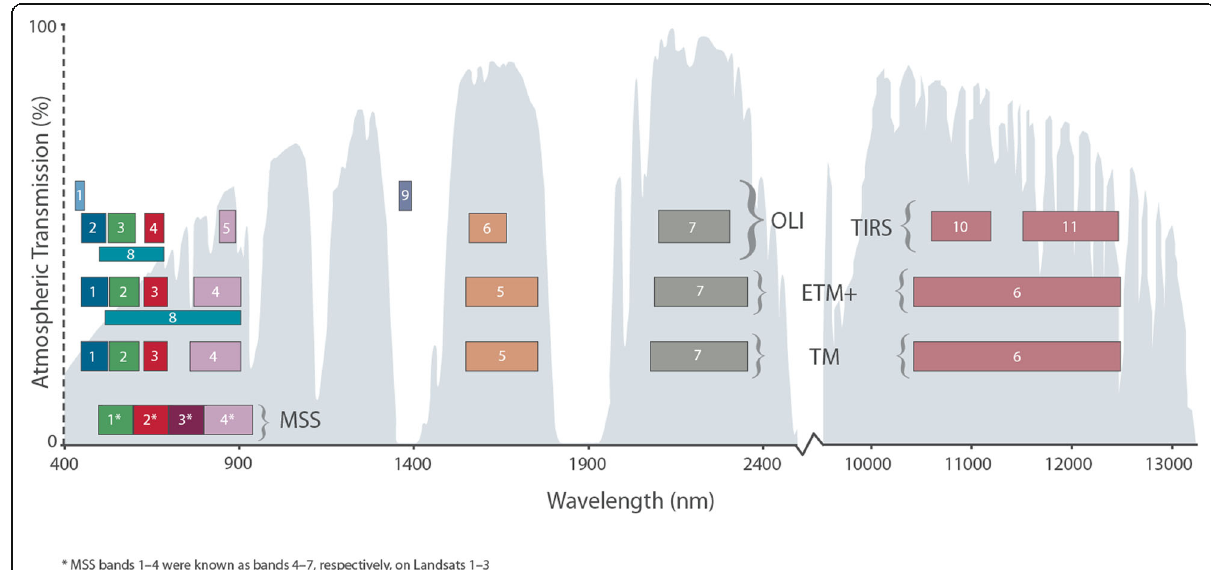
Fig. 2 Landsat bandpass locations, band width, and band number for optical and thermal imaging sensors for the Landsat satellites: The MultiSpectral Scanner (MSS) on Landsats-1 – 3 (Bottom row). L-3 had 80m pixels and a thermal band (not shown) at 240m pixel resolution; L-3 was terminated March 1979. The Thematic Mapper (TM) (Row 2) on Landsat-4 and Landsat-5, introduced 30m pixels for optical bands, adding three new bands (blue [1] and two SWIR [5, 7]) and a 120-m thermal band [6]. The Enhanced Thematic Mapper (ETM+) (Row 3) on Landsat-7 is similar to L-4 and L-5 but with a 15m panchromatic Visible-Near-Infrared (VNIR [8]) band and a TIR band with 60m pixels [6]. The Operational Land Imager (OLI) (Row 4) on Landsat-8 and Landsat-9 narrowed some bands and added two new bands [1, 9]; the 15-m pan band was limited to VIS [8]; and the TIR became two thermal bands TIRS1 and TIRS2 [10, 11] with 100 m pixels. The gray background shows regions of light (energy) transmission through the atmosphere to the Earth ’ s surface; in white areas, no solar energy gets to the land surface and back to the satellite, or for the thermal range, emitted from the surface. The common names for different wavelength regions are shown across the top of the figure. The numbering of the bands represents the order that the band was selected for inclusion on each Landsat. The atmospheric transmission values for this graphic were calculated in MODTRAN (MODerate resolution atmospheric TRANsmission computer code, MODTRAN 6, 2014) for a summertime mid-latitude hazy atmosphere (circa 5km visibility). Graphic created by L. Rocchio & J. Barsi. Figure from